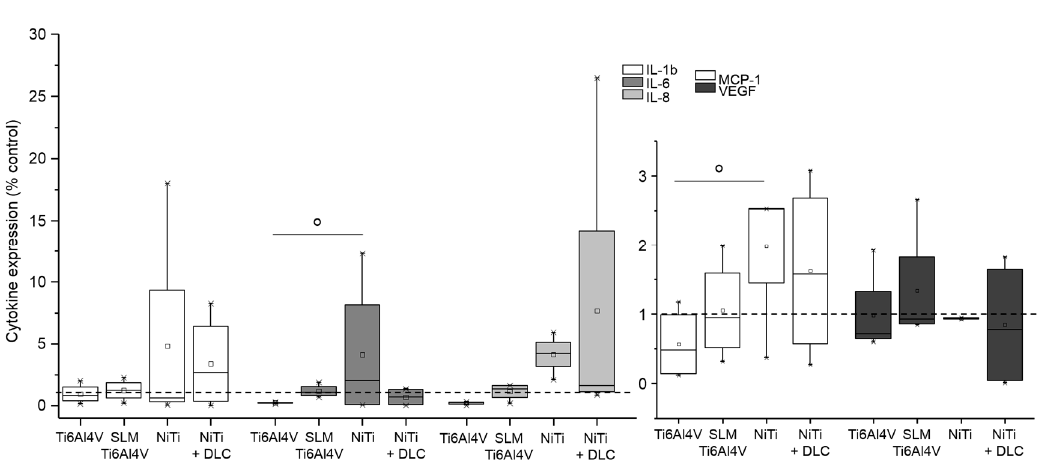
Figure 11. Cytokine level of IL-1b, IL-6, IL-8, MCP-1, and VEGF in supernatants of human fibroblasts ( n = 4) after 96 h of cultivation on several test pellets (forged Ti6Al4V, Ti6Al4V SLM, NiTi, and NiTi + DLC). Data were normalized to the growth control (=100%, dotted line). Boxes denote interquartile ranges, horizontal lines within the boxes denote medians, and whiskers denote minimum and maximum values. For statistical analysis, ANOVA was conducted. A p -value < 0.05 was considered statistically significant. Comparison to growth control: no significances. Comparison between several test pellets: ° p < 0.05.